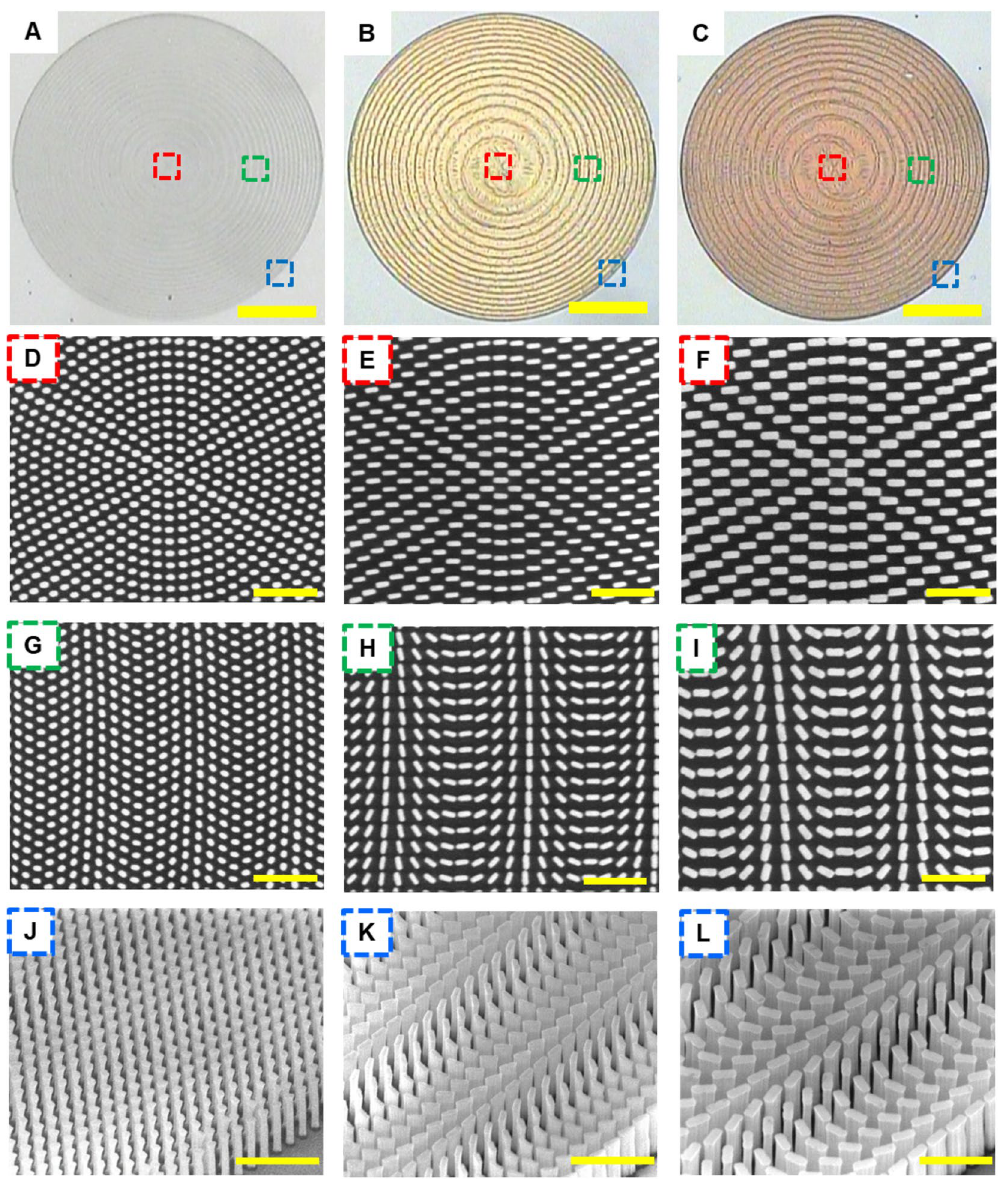
Figure 2. Micrographs of the metalenses. ( A – C ) Optical images of the fabricated metalenses designed at wavelengths of ( A ) 405, ( B ) 532, and ( C ) 633 nm. Scale bar: 25 μm. ( D – I ) The top-view SEM images shown in ( D , G ), ( E , H ), and ( F , I ) corresponding to the highlighted regions in ( A – C ), respectively. ( J – L ) The tilt-view SEM images shown in ( J ), ( K ), and ( L ) corresponding to the highlighted regions in ( A – C ). Scale bar, 1 μm in ( D – L